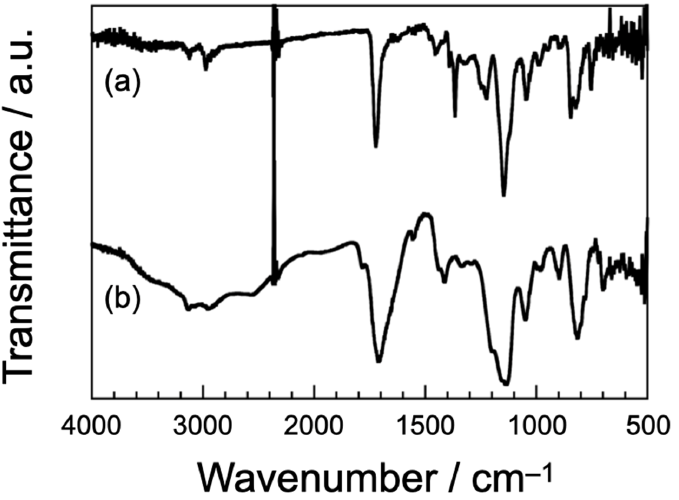
Figure 2. FTIR spectrum for poly(tBuAH) ( a ) and poly(AH) ( b ).